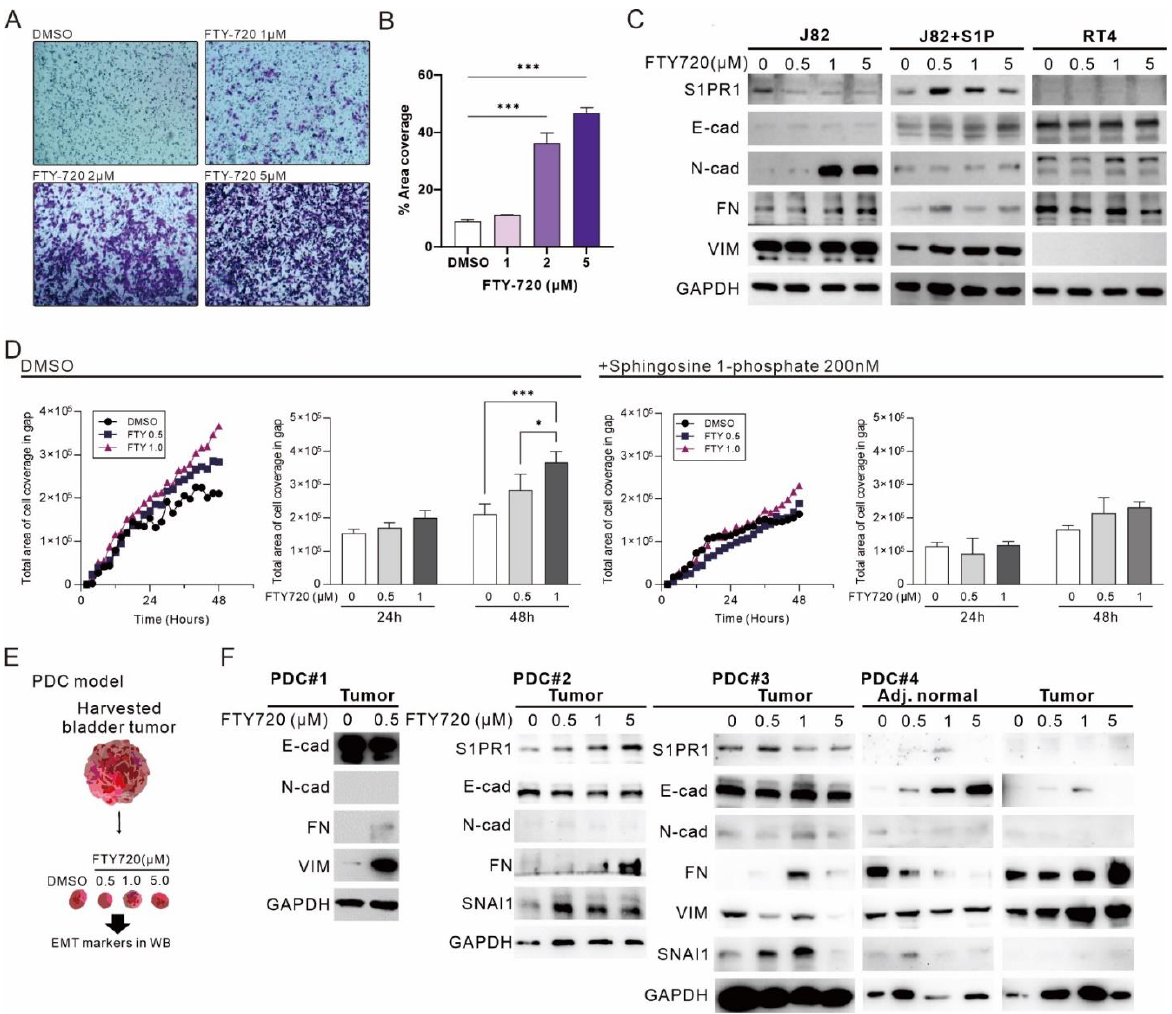
Figure 7. The administration of FTY-720 promotes EMT in bladder carcinoma. ( A ) Transwell migration assay showing the effect of FTY-720 treatment for 24 h (×100). ( B ) Area coverage (%) was calculated by quantifying the ratio of cell coverage per field using ImageJ. ( C ) Western blot showed the expression of S1PR1- and EMT-related markers after different dosage treatment of FTY-720 in J82 and RT4. Sphingosine 1-phosphate (200 nM) was added at the same time of FTY-720 treatment. ( D ) J82 cell gap coverage curves treated with FTY-720 in the presence and absence of S1P and statistical analysis of the number of cells in the gap at 24 h and 48 h. The curve data are presented as mean values only to reduce reading interference. ( E ) Illustration of patient-derived tumor culture (PDC) model. ( F ) Western blot showed four sets of clinical bladder cancer tumors with S1PR1- and EMT-related marker expression measured 48 h after FTY-720 addition. Bar charts are presented as the mean ± SD based on three independent experiments. * p < 0.05, ** p < 0.01, *** p < 0.001 (for uncropped Western Blot images, please refer to Figure S1).